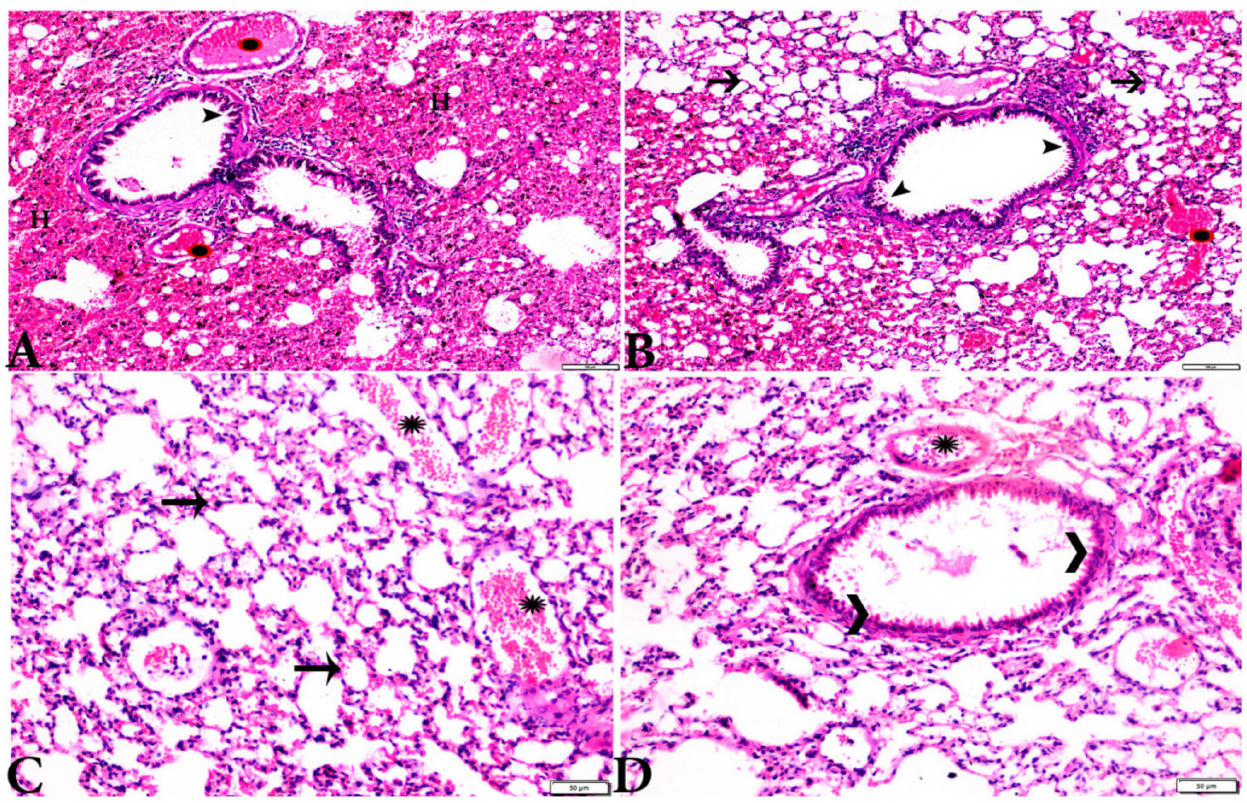
Figure 9. Photomicrograph of H&E-stained lung tissue sections from mice in the experimental groups: ( A , B ): lung tissue sections from T. gondii -infected mice treated with wheat germ oil (G4) showing: normal bronchiolar structure (arrowheads), congested blood vessel (stars), hemorrhage (H), and collapsed alveoli (arrows). ( C , D ): Lung tissue sections from the group treated with the combination of propolis and wheat germ oil (G5) showing: normal alveolar tissue (arrows), normal bronchiolar structure (arrowheads), and vascular congestion (stars). The scale bar is provided below each